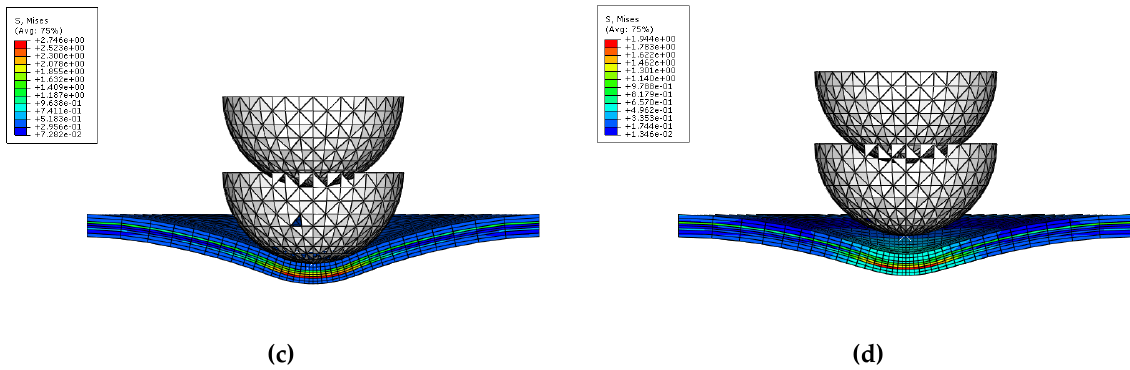
Figure 12. Second impact applied on GLARE 5-2/1: ( a ) Time = 0 ms, ( b ) Time = 0.26 ms, ( c ) Time = 2.22 ms, ( d ) Time = 5.35 ms.